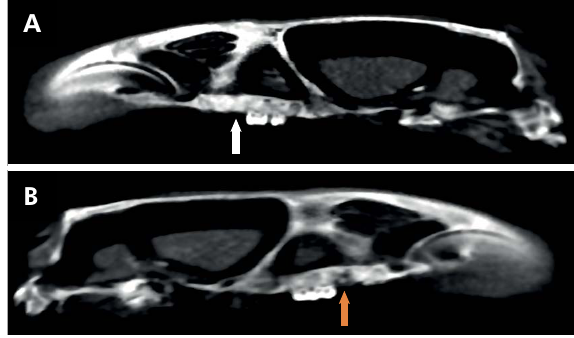
Figure 1. Micro-tomographic scan along sagittal plane of the skull in a rat. Micro- computed tomography features of alveolar socket healing. A (white arrow): showing almost complete mineralization in the experimental group. B (yellow arrow): showing a non-mineralized defect in the control